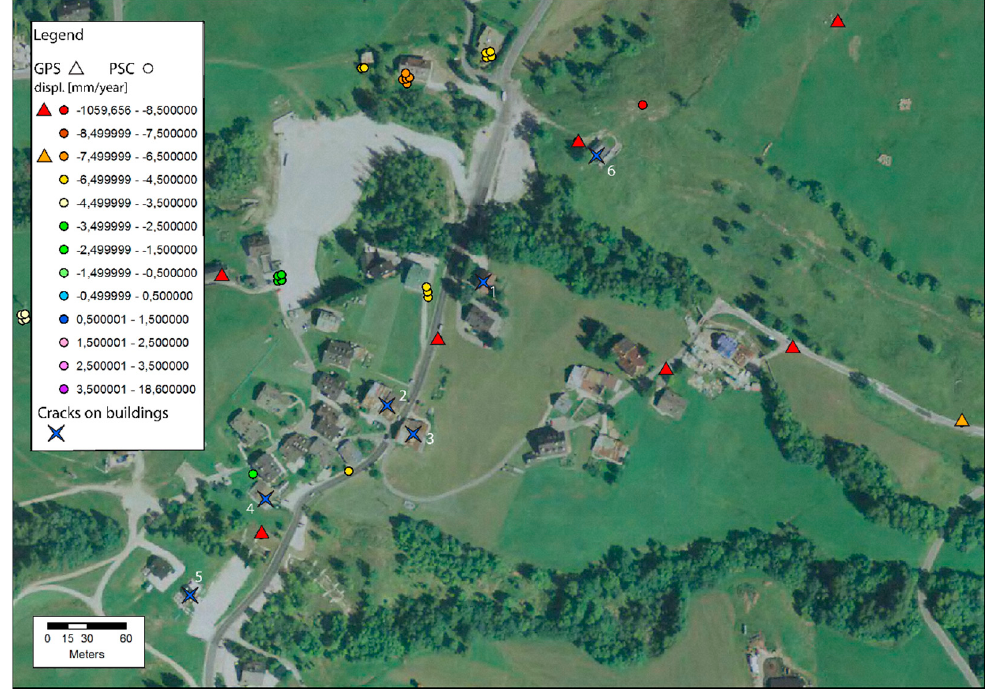
Figure 9. Confront between GNSS data, A-DInSAR data, and the location of buildings with damage.